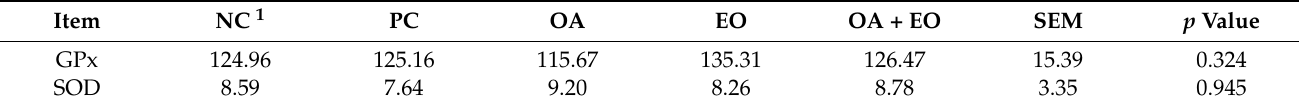
Table 4. Effects of individual or a combination of organic acids and essential oils on the activities of glutathione peroxidase (GPx; nmol/mg protein · min) and superoxide dismutase (SOD; U/mg per protein) in broiler chickens on D 35.